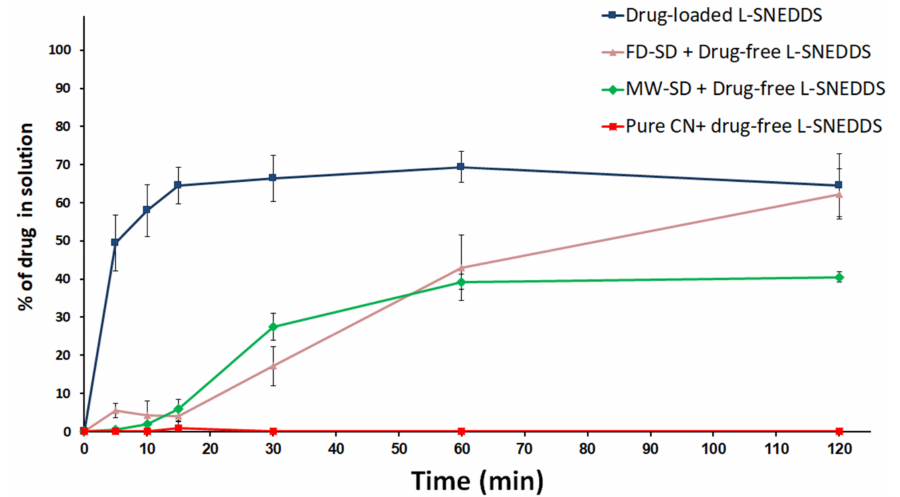
Figure 8. Effect of (SD + L-SNEDDS) combination on CN dissolution at pH 6.8. Data are expressed as mean ± SD. n = 3 for drug-loaded L-SNEDDS; n = 4 for MW-SD + Drug-free L-SNEDDS; n = 6 for FD-SD + Drug-free L-SNEDDS and Pure CN + drug-free